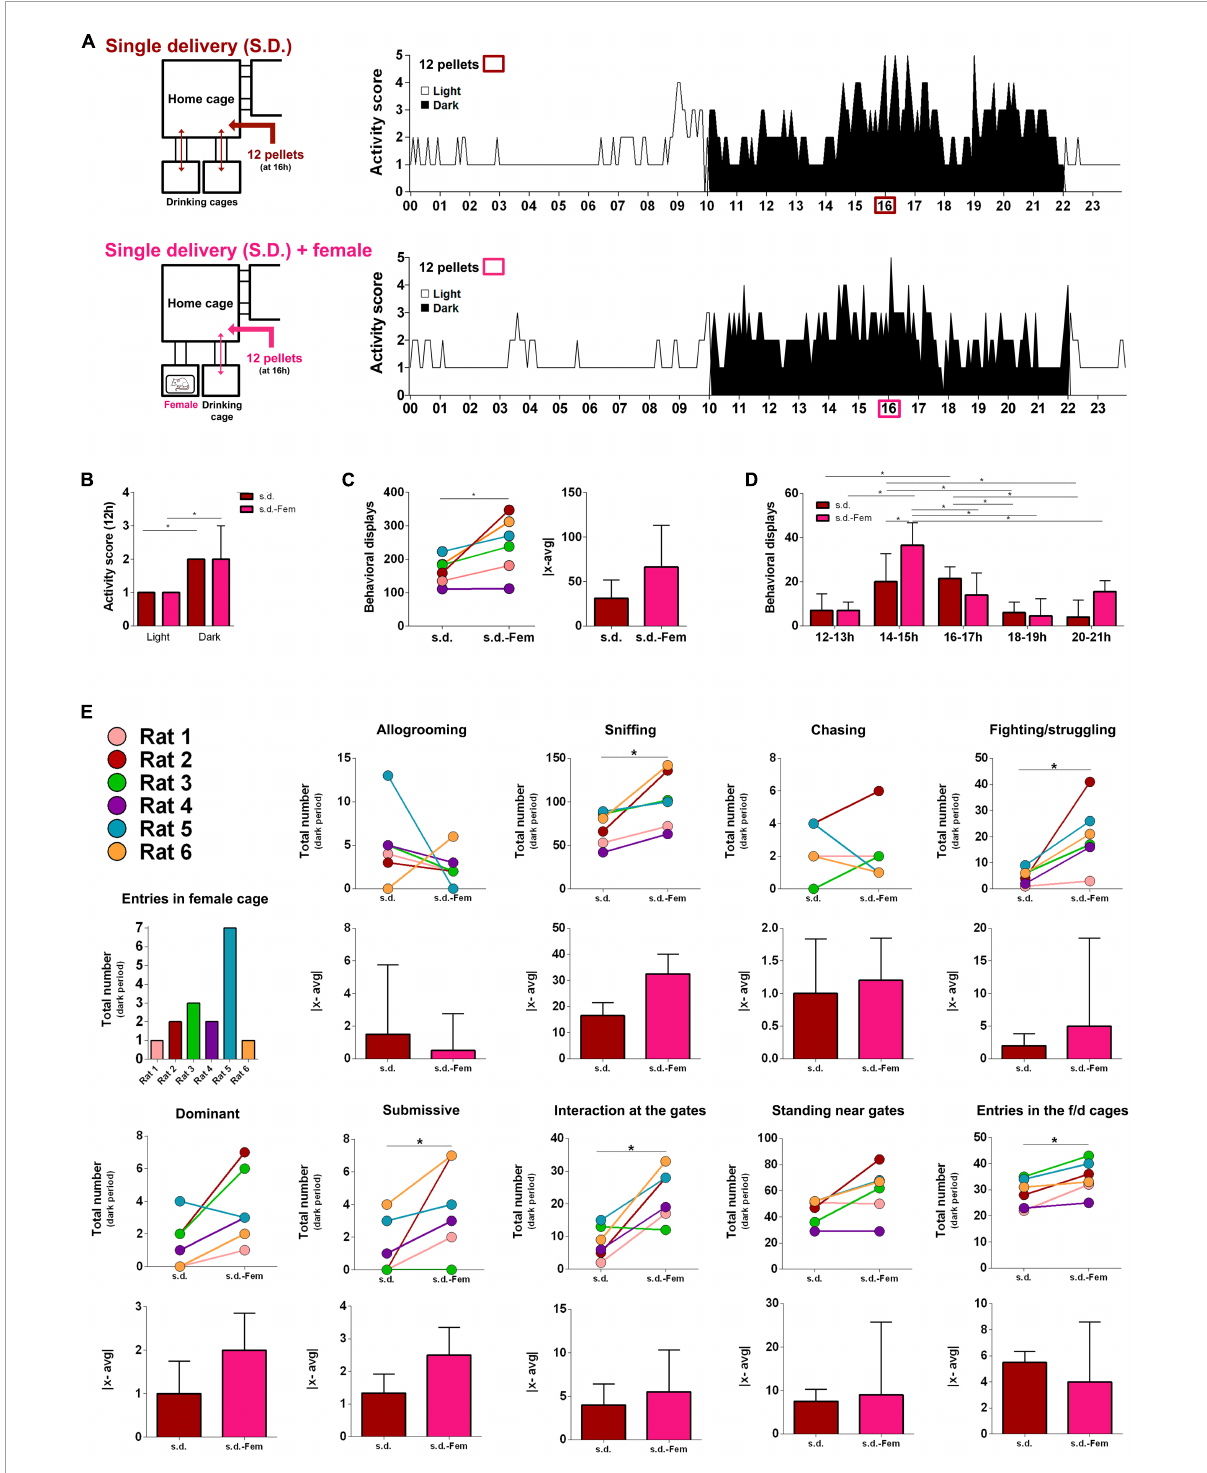
FIGURE3 Presence of a female rat cage induced an increase in the number of behaviors. (A) Representative graphs of the activity score of the six rats, in the home cage, in the deprived (single daily deliver of 2 pellets/rat at 16 h) and deprived in the presence of a female. (B) The presence of a female had no effect on the activity scores in the dark and light periods but (C,D) increased the number of behavioral displays; (E) specifically sniffing, fighting/struggling and submissive, interaction at the gates and entries in feeding/drinking cage. Results are presented as median and IQR; n = 6/group, * p < 0.05, Wilcoxon